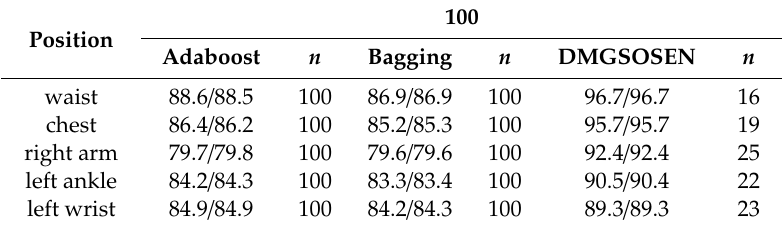
Table 12. Performance comparison with Adaboost and Bagging on 100 ELMs (Accuracy / F1%).